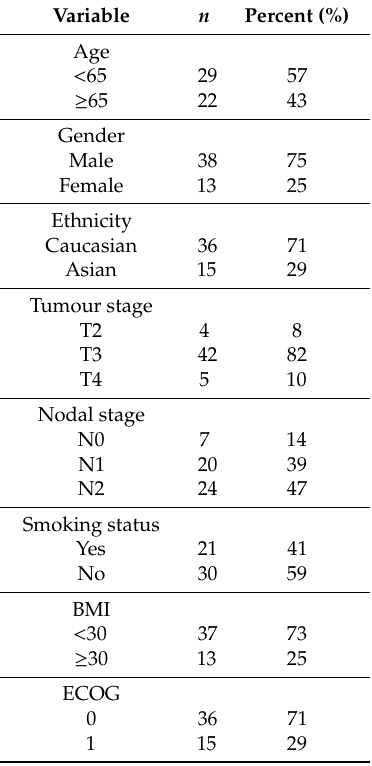
Table 1. Demographics and clinical profile of patient sample at baseline ( n =